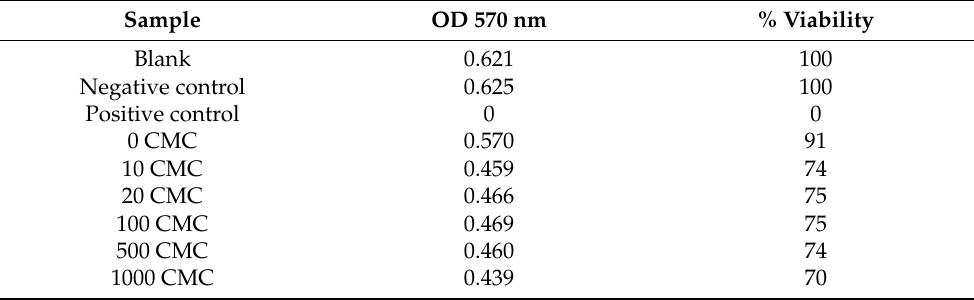
Table 4. Percentage of cell viability using the MTT cytotoxicity